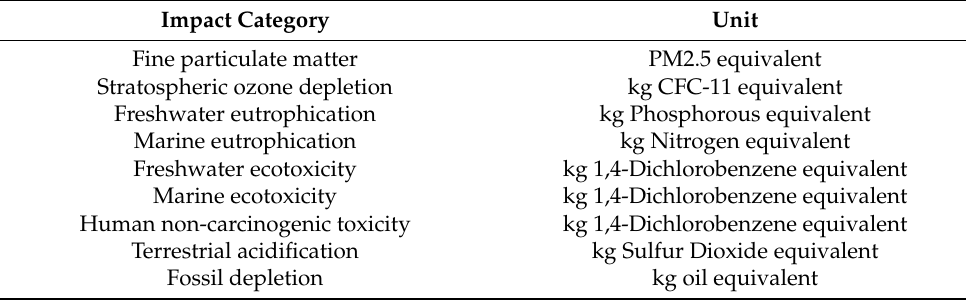
Table 3. Additional ReCiPe 2016 LCIA midpoint impacts